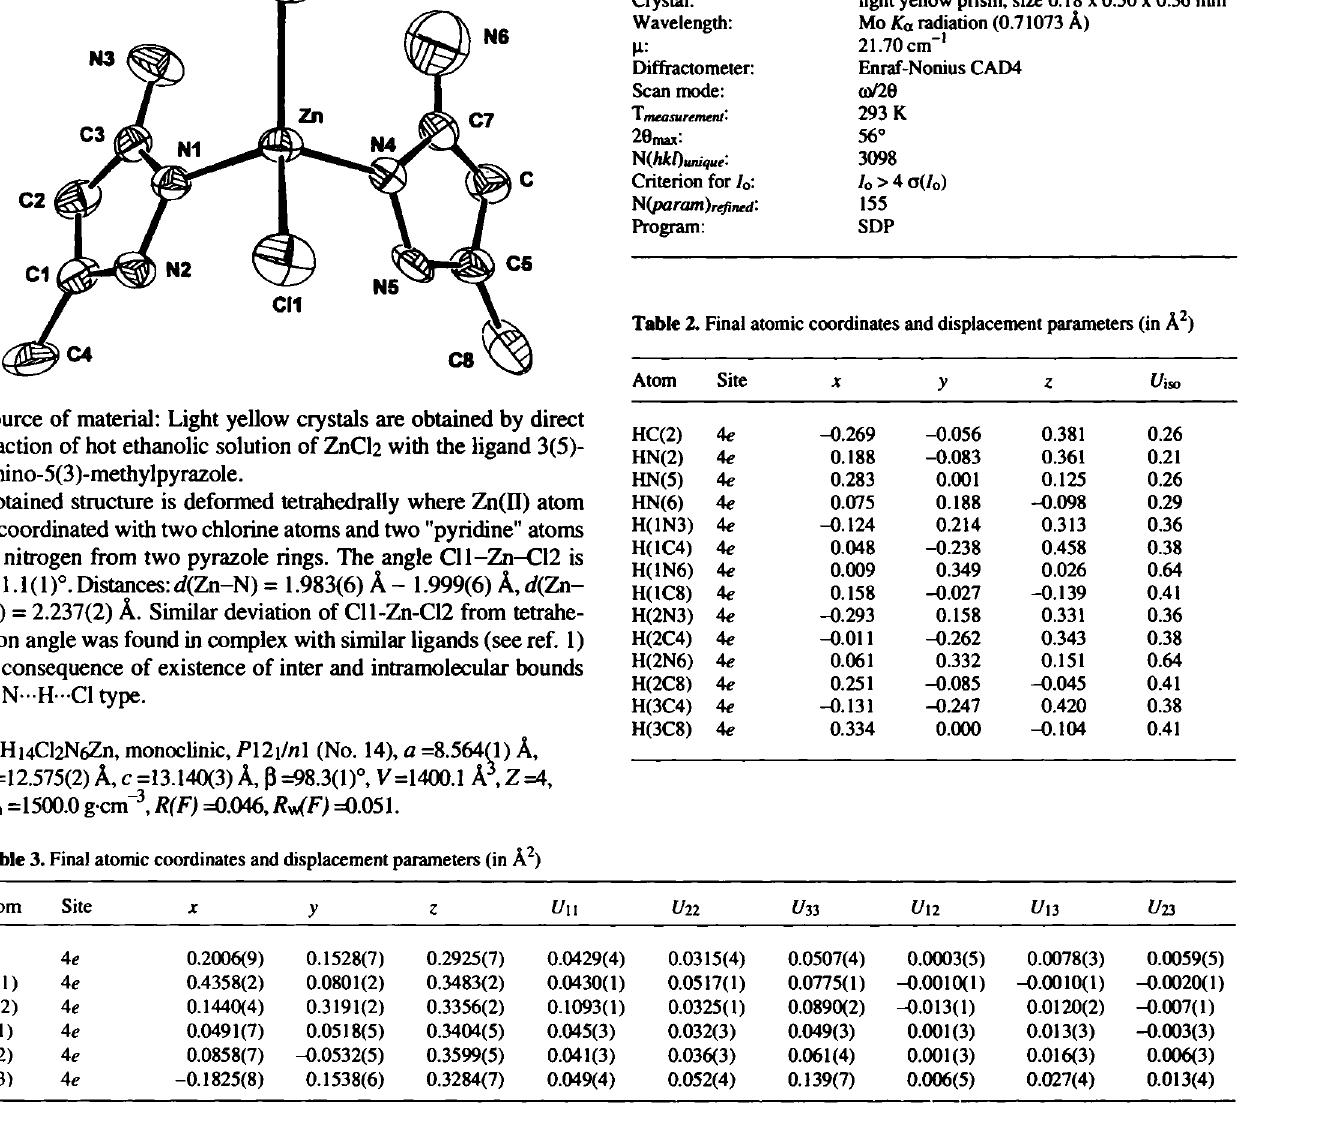
Table 2. Final atomic coordinates and displacement parameters (in